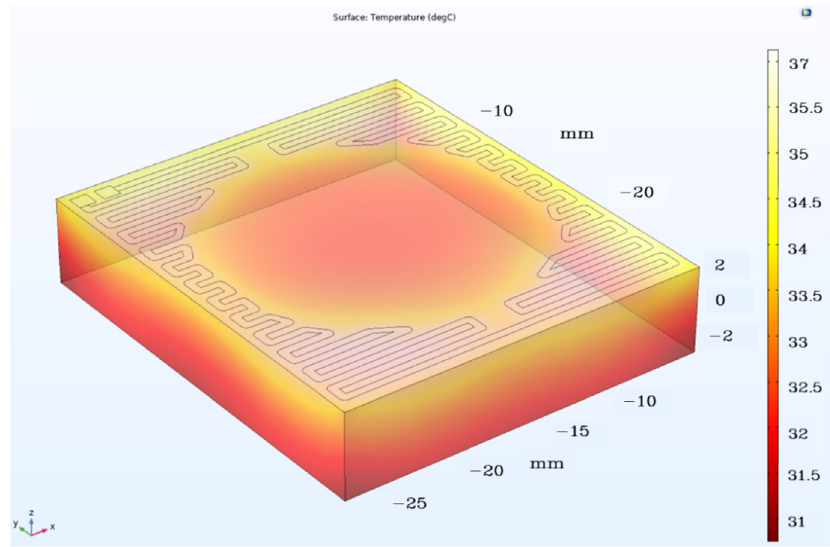
Figure 12. Thermal analysis using finite element software (COMSOL).